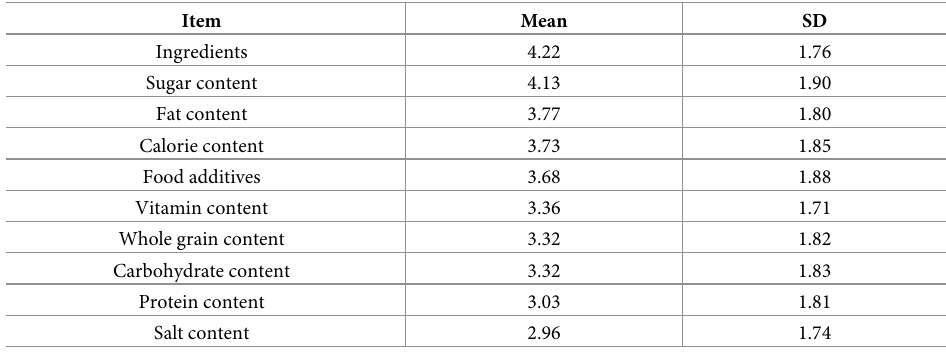
Table 2. Importance of food characteristics in grocery